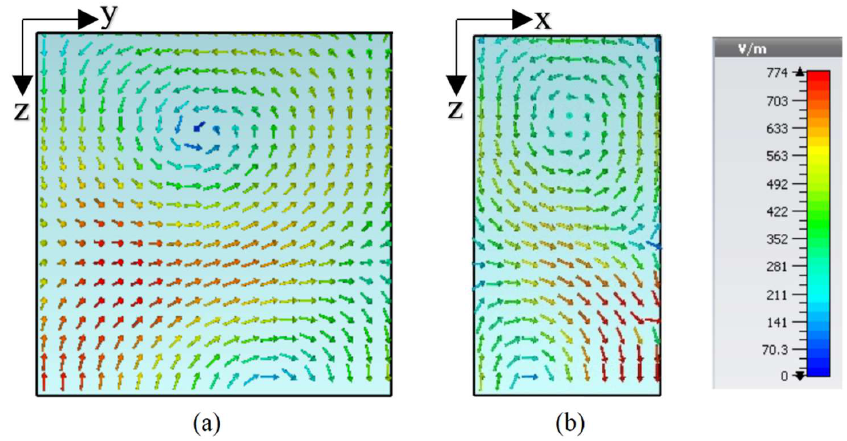
y at 4.52 GHz. δ 13 at 4.13 GHz; ( b ) TE 1 δ 3